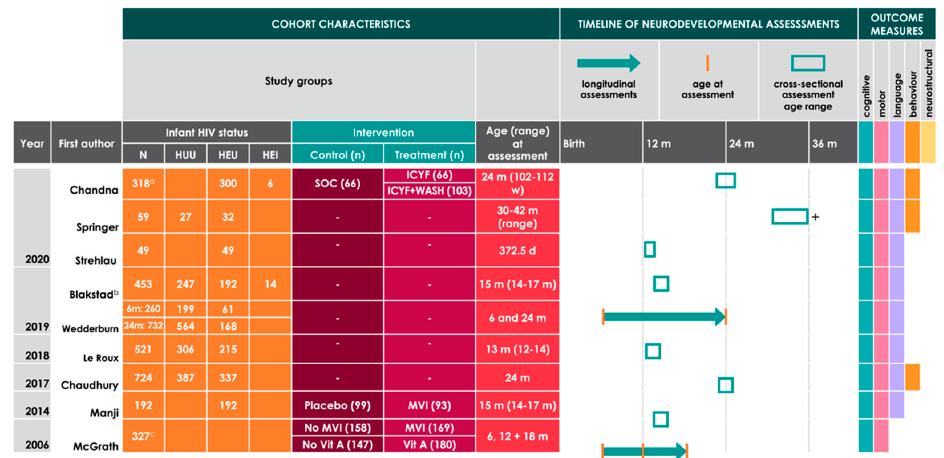
Figure 2. Adapted Graphical Overview for Evidence Reviews (GOfER) diagram [34] of studies reporting on early life nutritional factors and neurodevelopmental outcomes in infants affected by exposure